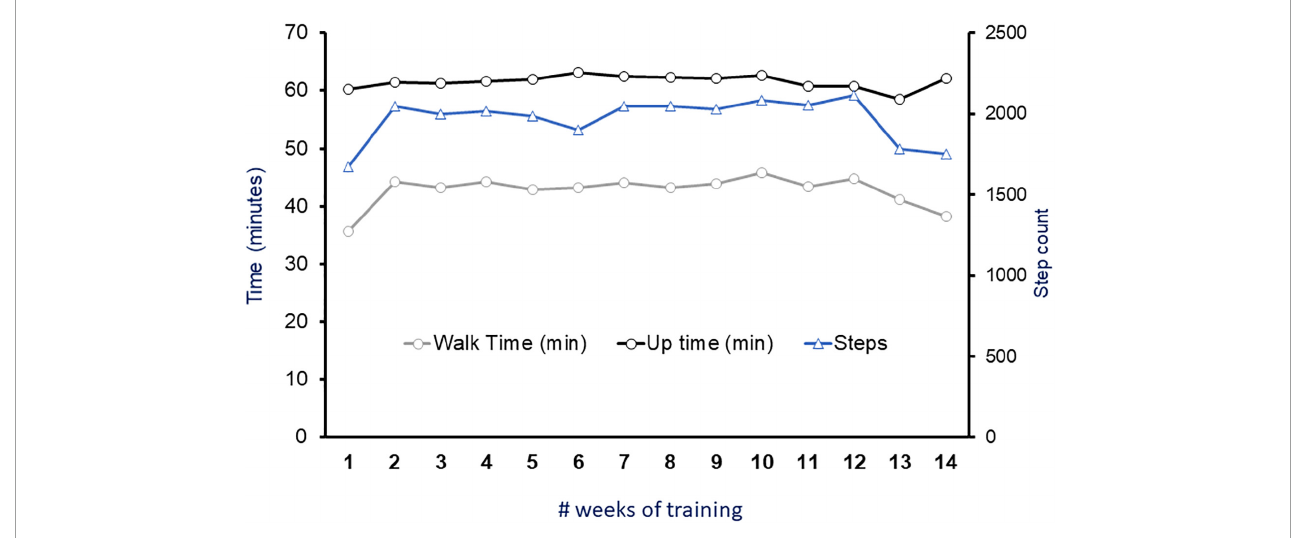
FIGURE3 Fourteen weeks of exoskeleton walking training. Each week consisted of an average of three sessions per week. Circles represent time (minutes) for average total walk time and uptime. Triangles represent average total number of steps achieved throughout each week of training. During this period, exoskeleton was set at a variable assist mode to enable stepping with SCES on during 60 min of